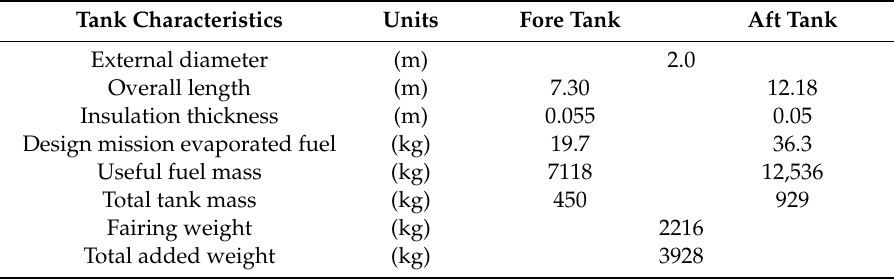
Table 7. Sized LNG aircraft tanks.